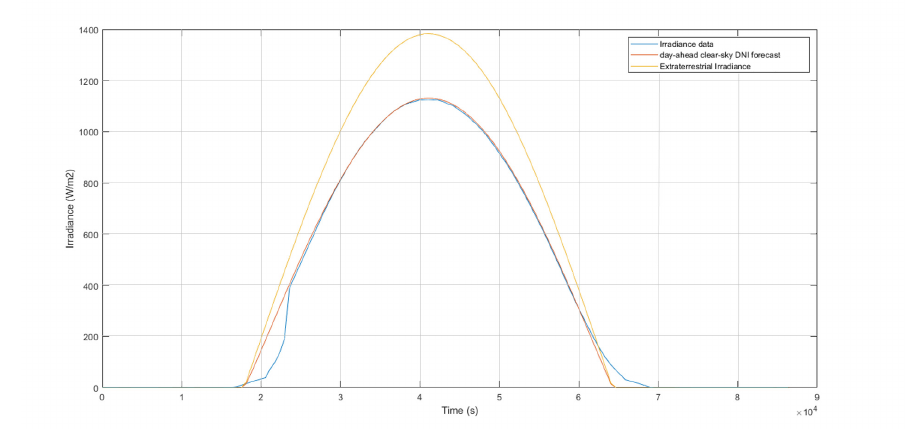
Figure 3. Comparison of computed extraterrestrial irradiance (yellow), irradiance data measured with the panels pyranometer (blue), and clear sky direct normal irradiance (DNI) estimation (orange). Date: